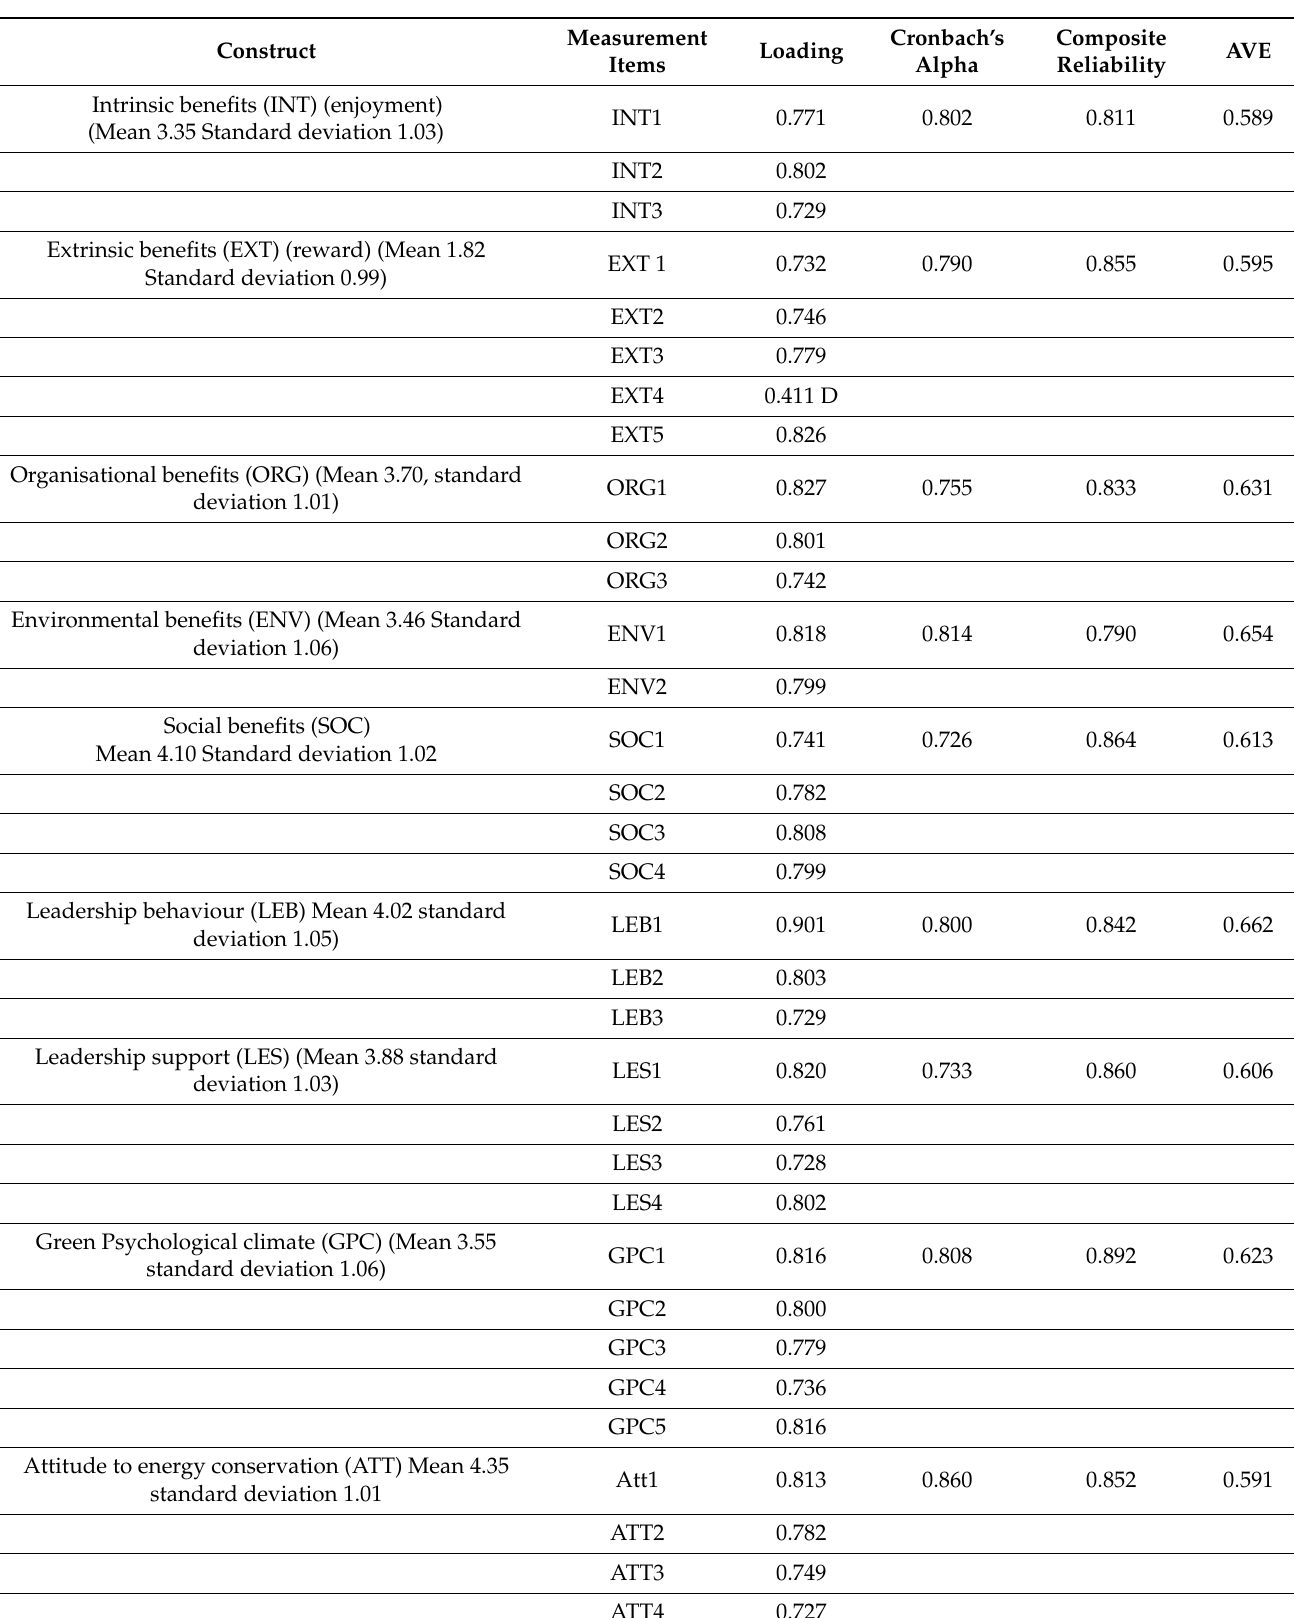
Table 1. Measurement